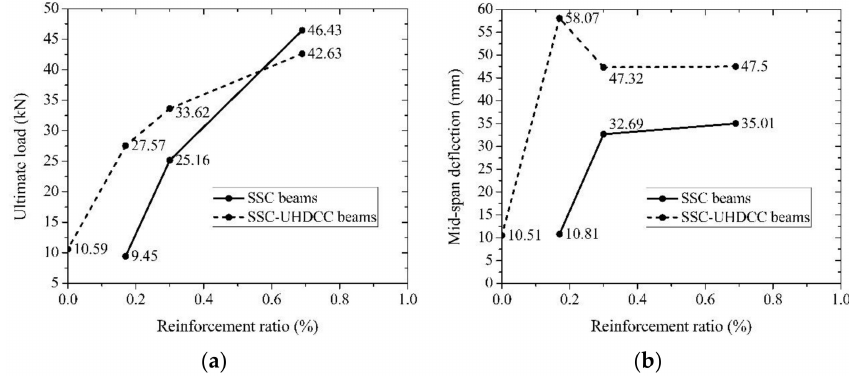
Figure 14. Ultimate load and mid-span deflection of beams: ( a ) ultimate load; and ( b ) mid-span